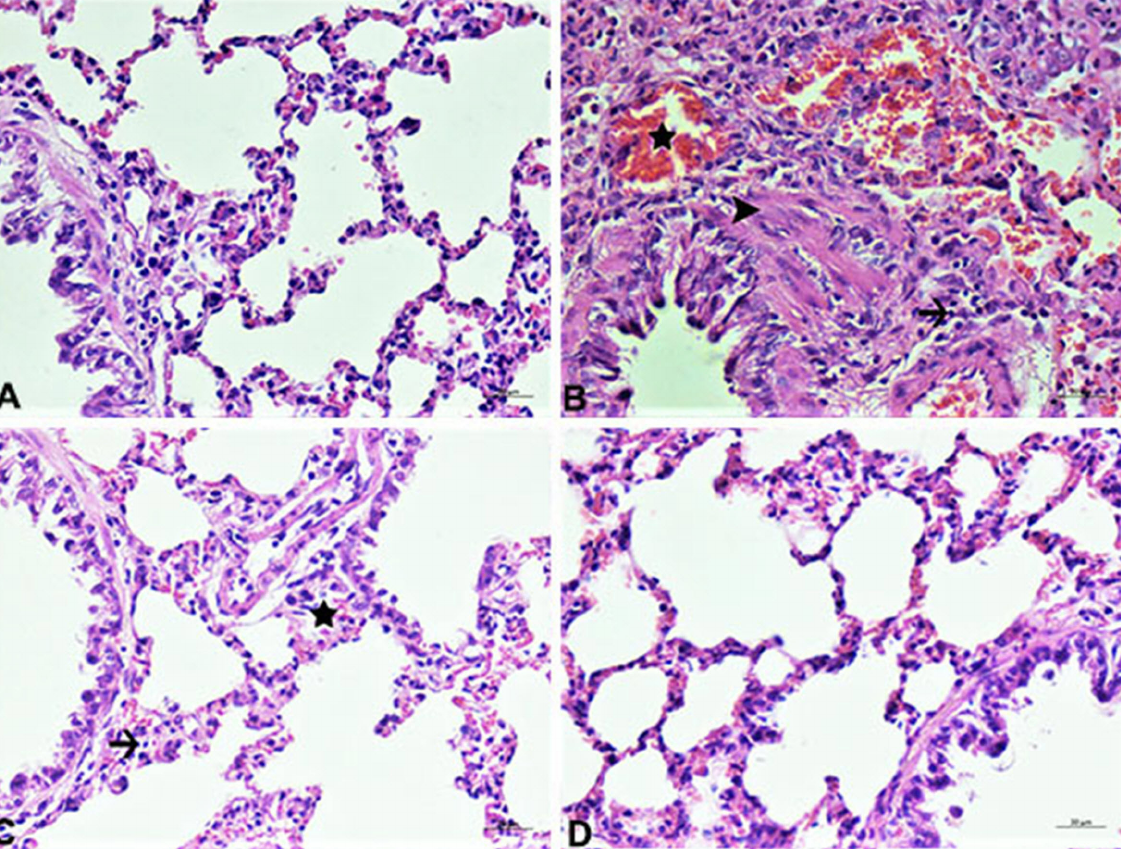
FIGURE 1 - The lung tissue, control group, normal histological appearance (A), section taken from the lungs of rats given BLM, BLM group, peribronchiolar and interstitial fibrosis (arrowheads), peribronchiolar cell infiltration (arrow), interstitial pneumonia, severe level hyperemia in the vessels (star) (B), section taken from the lungs of rats given both BLM and Theo, BLM+Theo group, mild level of interstitial pneumonia (star), moderate hyperemia in the vessels (star) (C), Theo group, normal histological appearance (D), H&E, Bar: 20